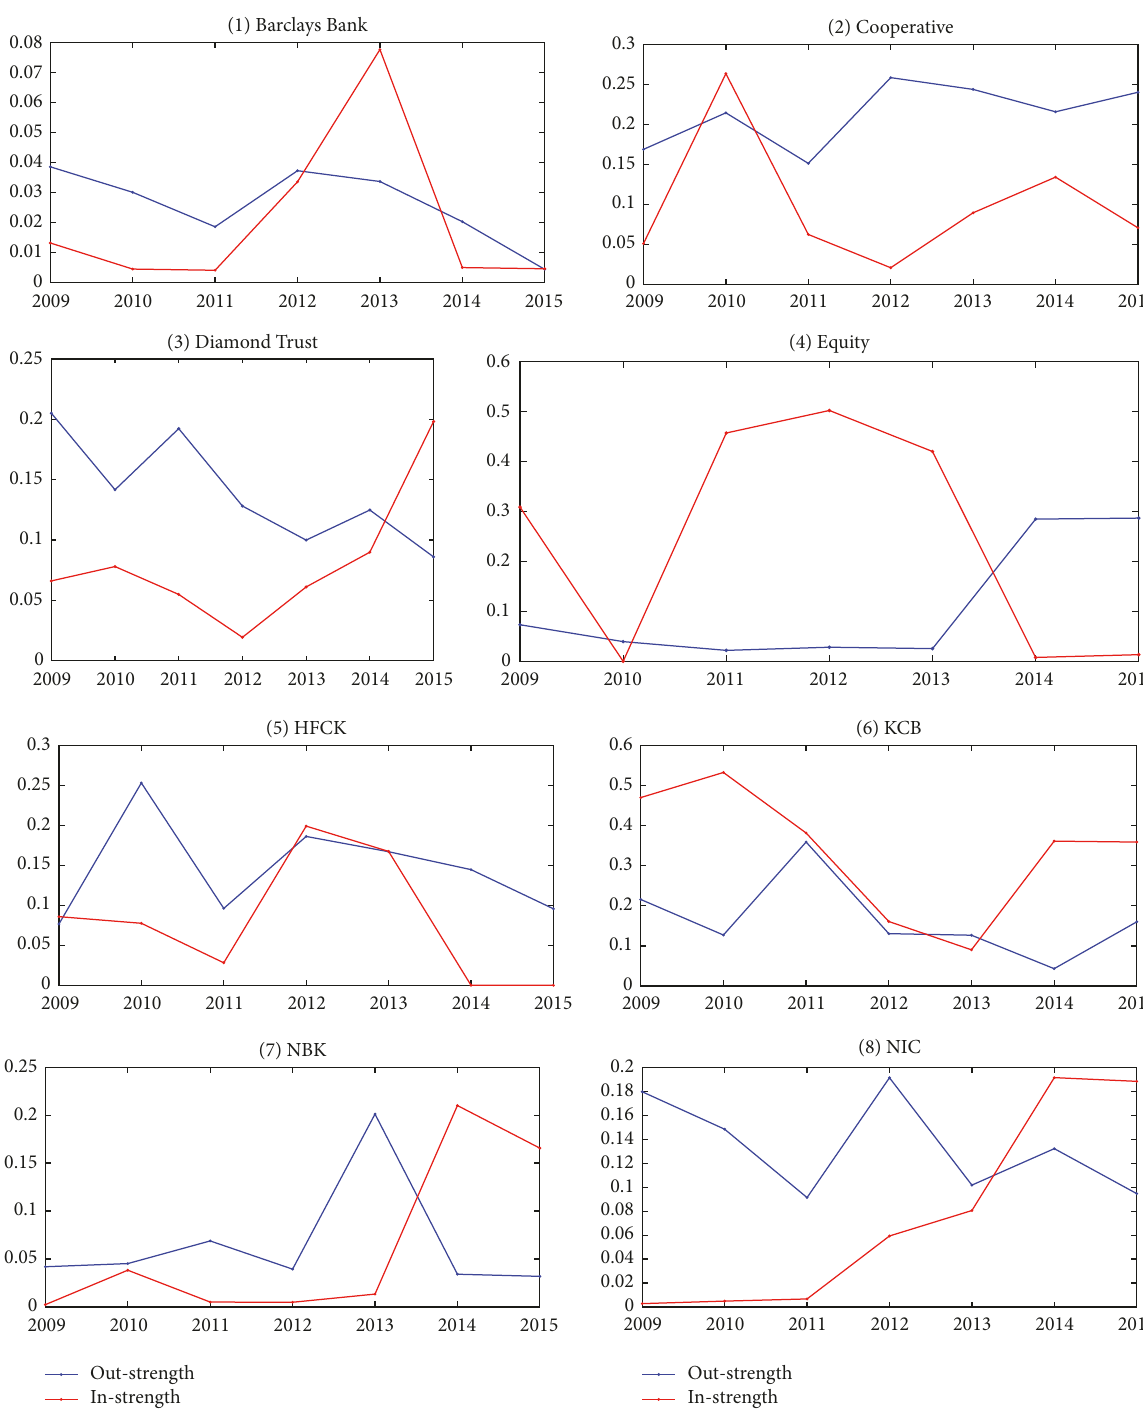
Figure 2: Time variations of in-strength and out-strength for 8 banks. The total strength is the sum of the in-strength (red line) and the out-strength (blue line). The vertical axis (the strength) shows the percentage of the amount of money borrowed or lent by a bank while horizontal axis represents time in